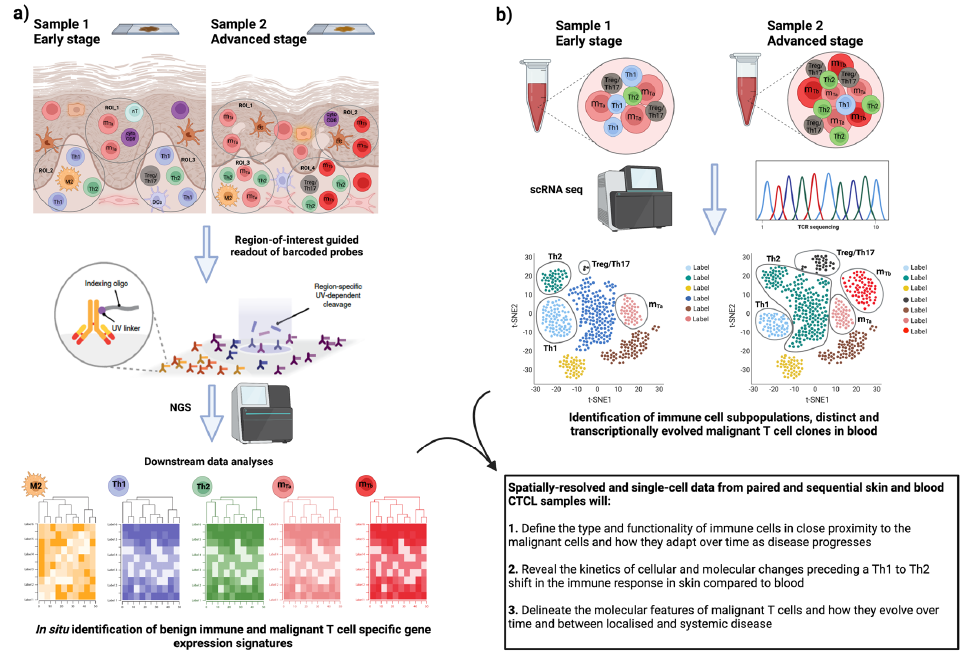
Figure 2. Phenotypic and functional profiling of benign and malignant immune cells in skin and blood CTCL samples with spatially resolved and single-cell transcriptomics. ( a ) Spatially resolved transcriptomics (SRTs) in the skin of MF and SS patients. Shown is an example of a workflow of an SRT technology, in which fl uorescently labeled immune cell subpopulations of interest guide gene expression pro fi ling of speci fi c regions of interest (ROIs). Subsequent downstream analysis pipe- lines shown to assist the identi fi cation of gene expression pa tt erns related to speci fi c reactive im- mune cell subpopulations and molecularly heterogeneous malignant T-cell subpopulations (desig- nated as m Ta and m Tb in pink and red color, respectively) and with respect to their spatial localization in the skin microenvironment in early and late-stage disease. ( b ) Parallel application of single-cell RNA sequencing (scRNA seq) in paired blood samples of CTCL patients. Shown the combined anal- yses to facilitate the identi fi cation of distinct and transcriptionally evolved malignant T-cell clones in relation to simultaneous changes in the frequency, abundance, and molecular pro fi le of the dif- ferent immune cell populations (Th1, Th2, and Treg/Th17 cells) when comparing early/localized and advanced/systemic disease. Proposed here, the comparison and integration of the fi ndings from se- quential skin and blood samples in CTCL patients to allow characterization of the intra-patient het- erogeneity and discovery of the unique e ff ector molecules and signaling pathways associated with disease severity and systemic progression over time. The fi gure was generated using BioRender software. 5. Conclusions—Future Research Directions Extreme inter- and intra-patient heterogeneity poses major di ffi culties in understand- ing the exact molecular events associated with CTCL progression and hinders the devel- opment of reliable prognostic biomarkers. While the emergence of advanced omics tech- nologies has undoubtedly enriched our knowledge regarding disease etiology and devel- opment, most of these approaches involve the destruction of tissue architecture, therefore limiting our ability to investigate the role of the TME composition and spatial organization in CTCL progression. We propose here that in future studies the application of SRT in skin biopsies will allow deep phenotypic and molecular characterization of diverse benign im- mune subpopulations in the skin microenvironment. Considering that blood involvement is associated with disease aggressiveness and progression, tissue-based analyses should be paralleled by single-cell transcriptomics to characterize benign and malignant immune populations in paired blood samples over time. Consequently, spatial pro fi ling of the